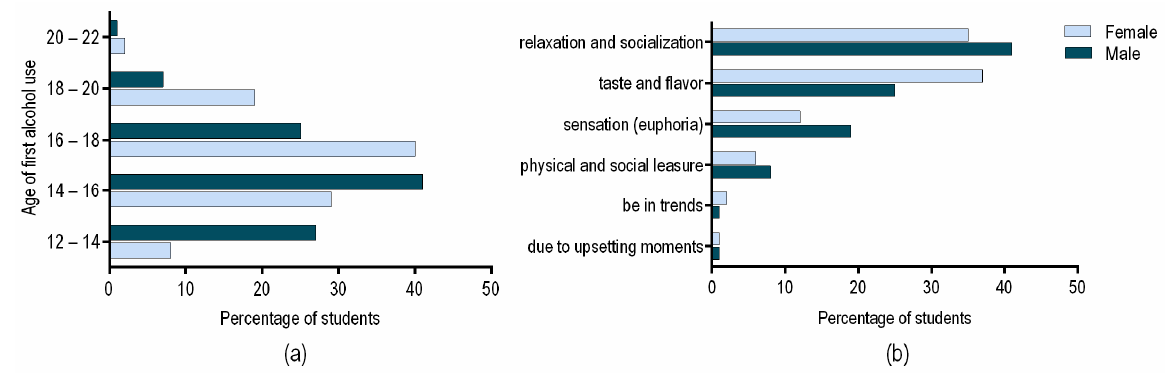
Figure 1. ( a ) The percentages of male and female students related to the age of their first alcohol use; ( b ) The main reasons why male and female students are consuming